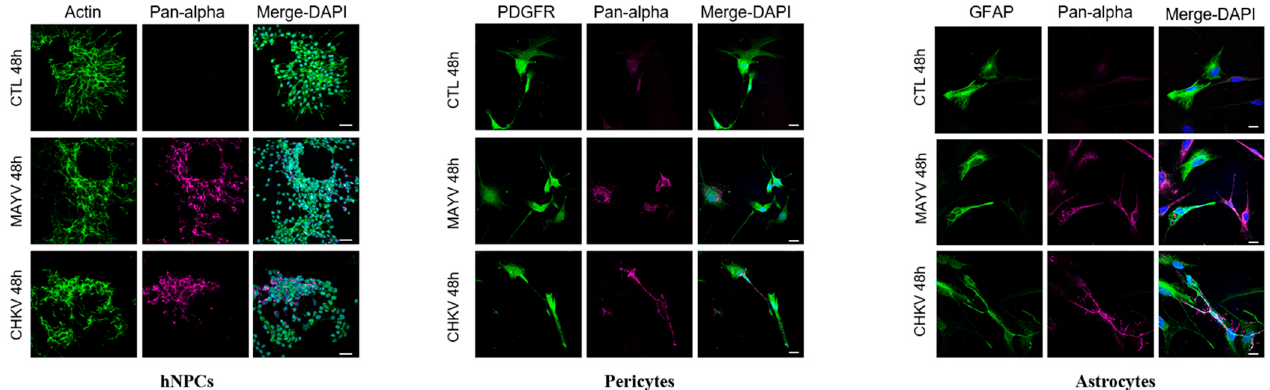
Figure 2. MAYV and CHIKV infect human neural progenitors (hNPCs), astrocytes and pericytes. Cells were infected with either MAYV or CHIKV at MOI 5 for 48 hpi, fixed and stained by indirect immunofluorescence for the detection of actin (hNPCs, ActinProbe, green), platelet-derived growth factor receptor (PDGFR) (pericytes, green), glial fibrillary acidic protein (GFAP) (astrocytes, green) and MAYV and CHIKV envelop protein (anti-pan-alphavirus; magenta). Nuclei are counterstained using Hoechst (blue). Scale bars equal to 30 µ m (hNPCs) and 20 µ m (pericytes and astrocytes). Mock-infected cells were used as control (CTL).